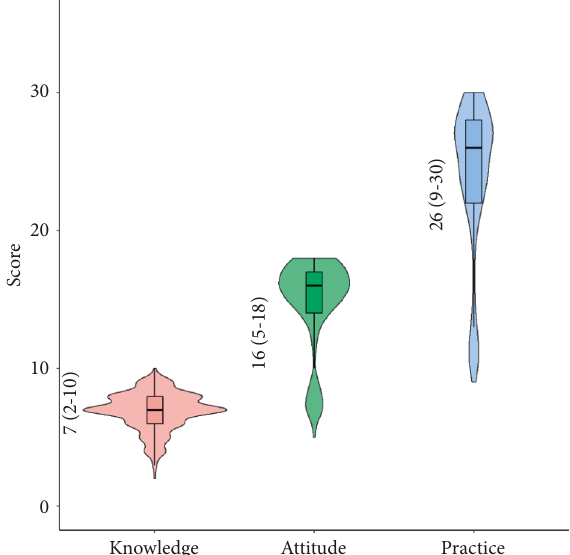
Figure 2: Violin plots showing the distribution of knowledge, attitude, and practice scores among participants. (The numbers shown on the left side represent the median (IQR). Note that the possible score range of knowledge, attitude, and practices are 0–10, 0–18, and 0–30,